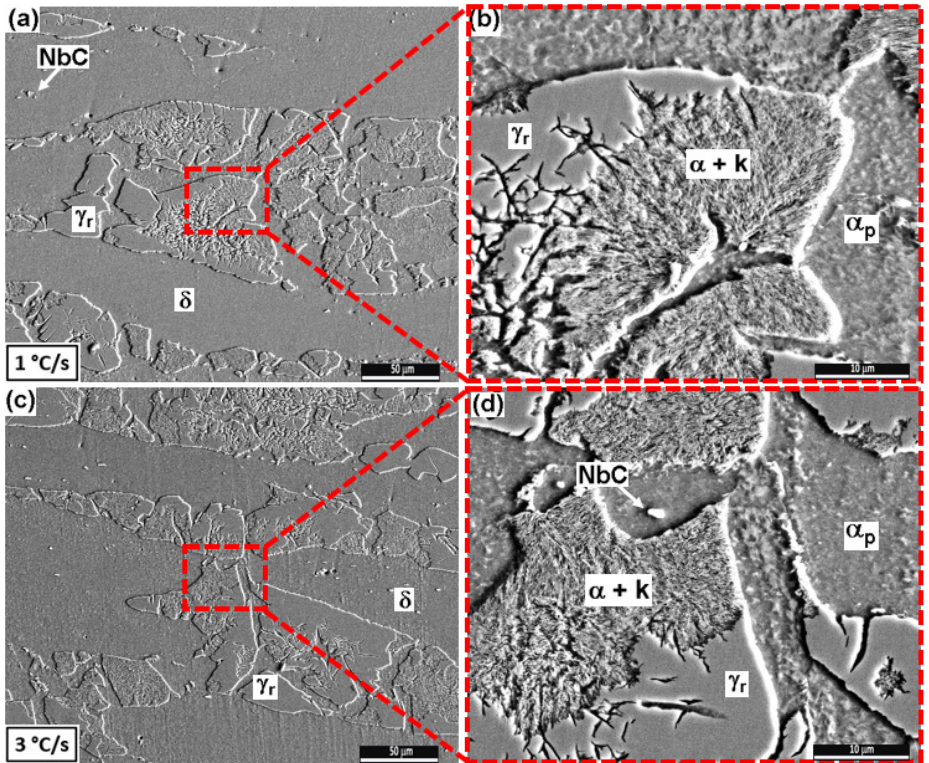
Figure 4. Micrographs (SEM/SE) of samples tested at low cooling rates of 1 °C/s ( a , b ) and 3 °C/s: ( c , d ) ( γ r = retained austenite; δ = δ -ferrite; α = α -ferrite; α p = proeutectoid α -ferrite; k = k-carbide; NbC = niobium carbide).